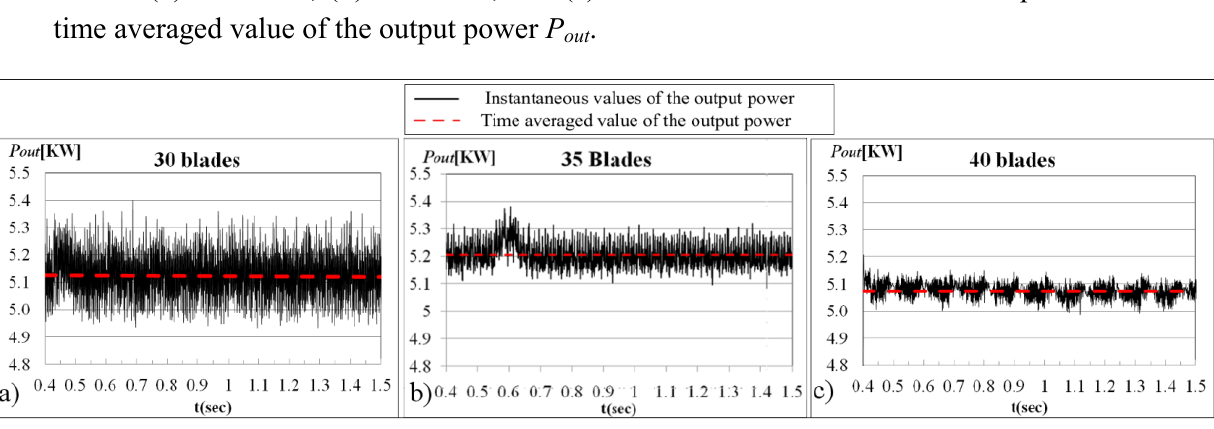
Figure 8. Time series of the output power P blades: ( a ) 30 blades; ( b ) 35 blades; and ( c ) 40 blades. The red dotted lines represent the time averaged value of the output power P